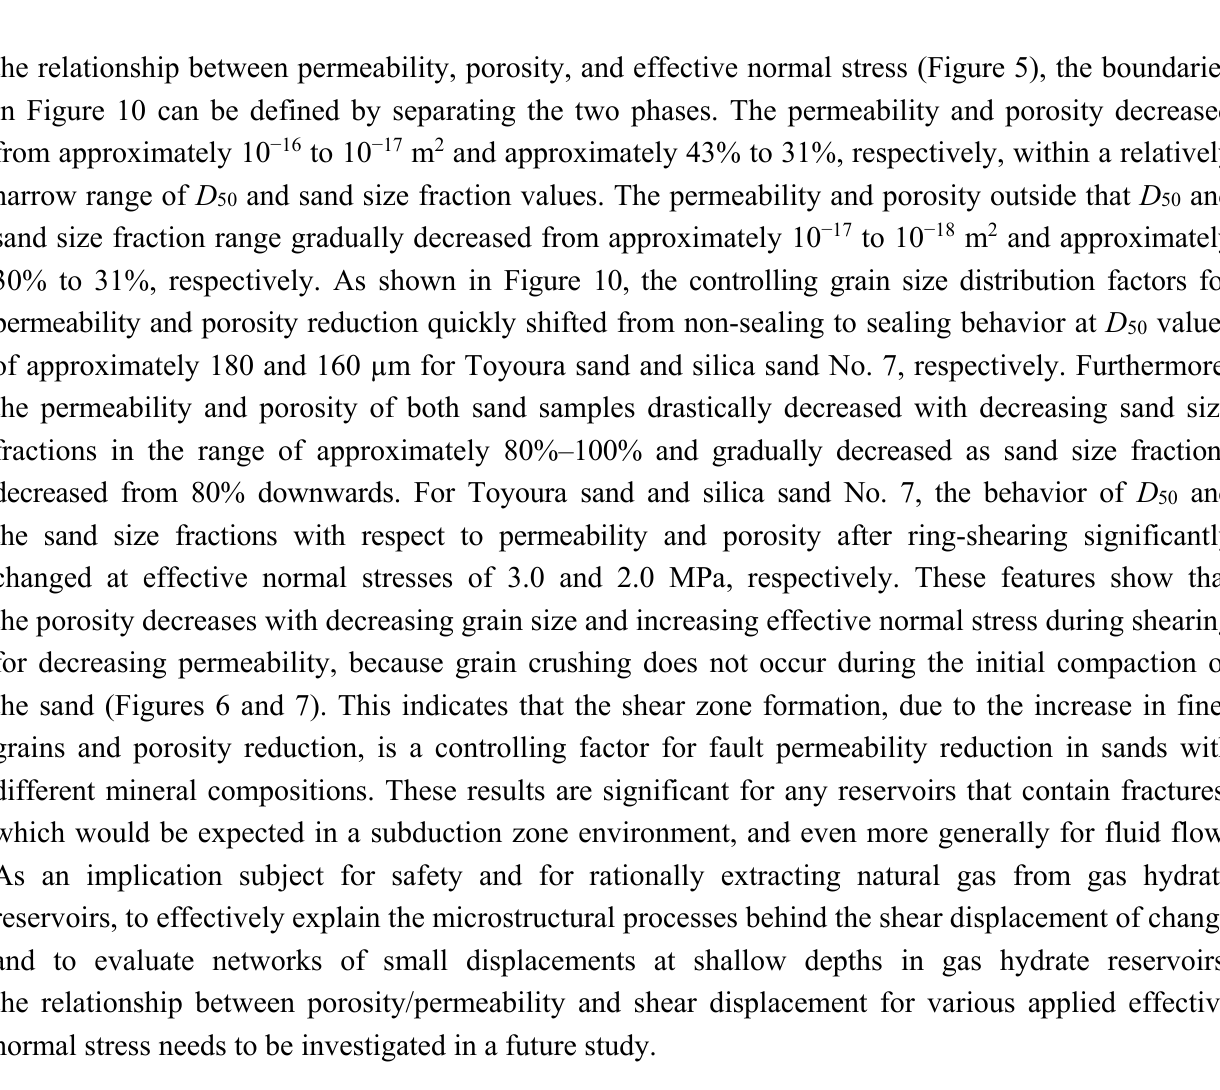
Table 4. Correlations and statistical fits obtained from various correlations in Figure 10.